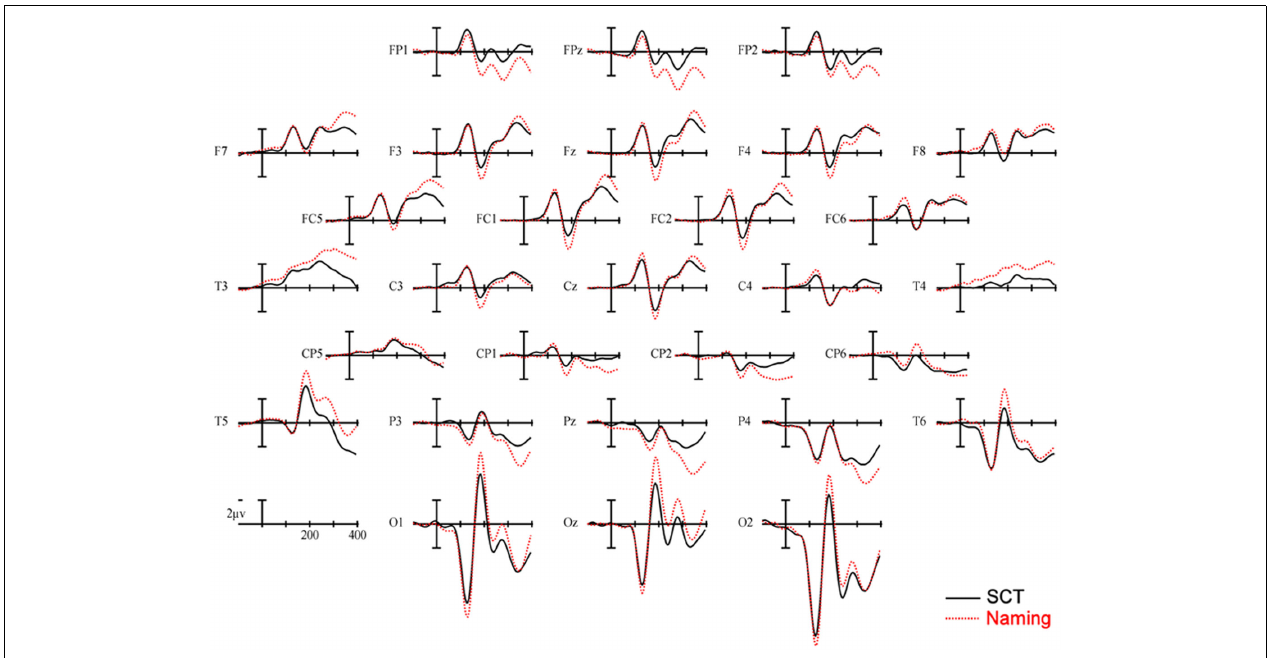
FIGURE 3 | Main effect ofTASK. ERPs collapsed across item type. Solid lines are ERPs from all 28 scalp sites during a semantic categorization task (SCT) and dashed lines are ERPs recorded to the same stimuli in a naming task. Stimulus onset is the vertical calibration bar and each tic mark on the x -axis is 100ms.